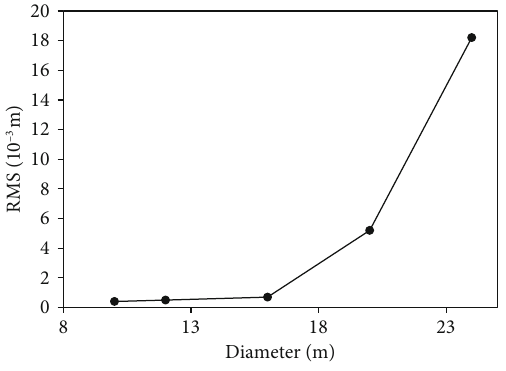
Figure 11: Deviation between P g